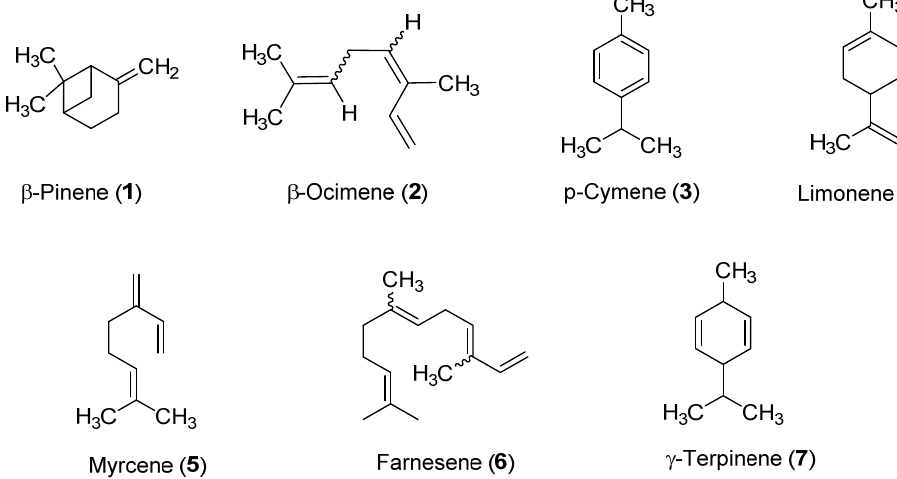
Figure 1. Growth inhibition of T. brucei s427 cells by A. nemorosa EO from aerial parts (EO-AP) and roots (EO-R) and by farnesene. ( A ). Growth inhibition of T. brucei treated with EO-AP (red curve) and EO-R (green curve) with Suramin as control (purple curve). ( B ). T. brucei growth inhibition with farnesene.